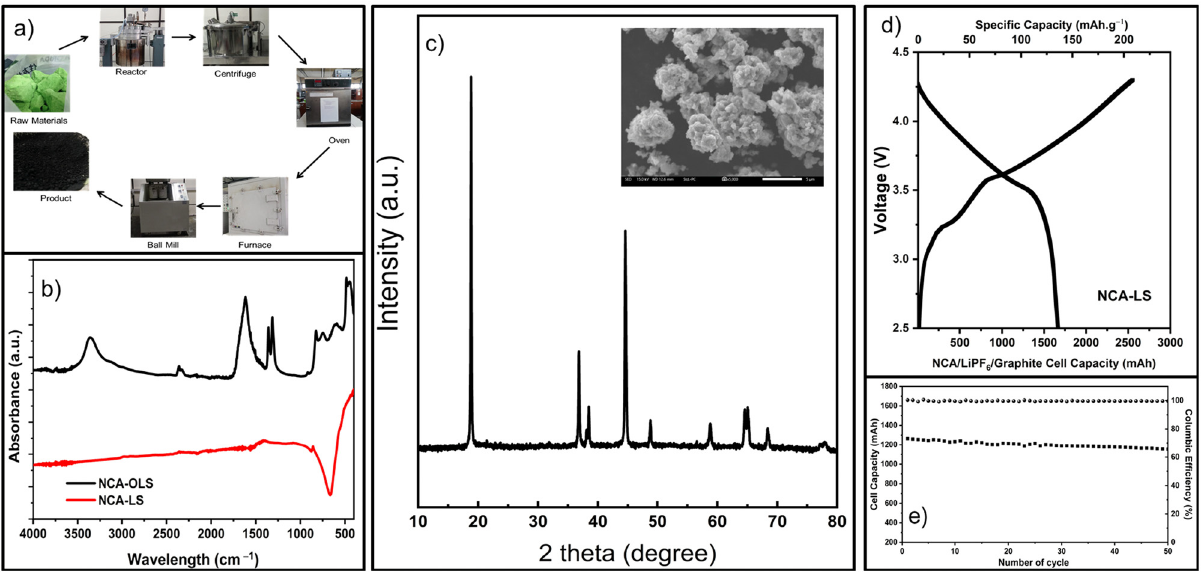
Figure 7: ( a ) Flow diagram of 2 kg per batch of NCA production and product ( NCA - LS ) characterization by ( b ) FTIR, ( c ) XRD/SEM, ( d ) charge – discharge performance test, and ( e ) cycle performance